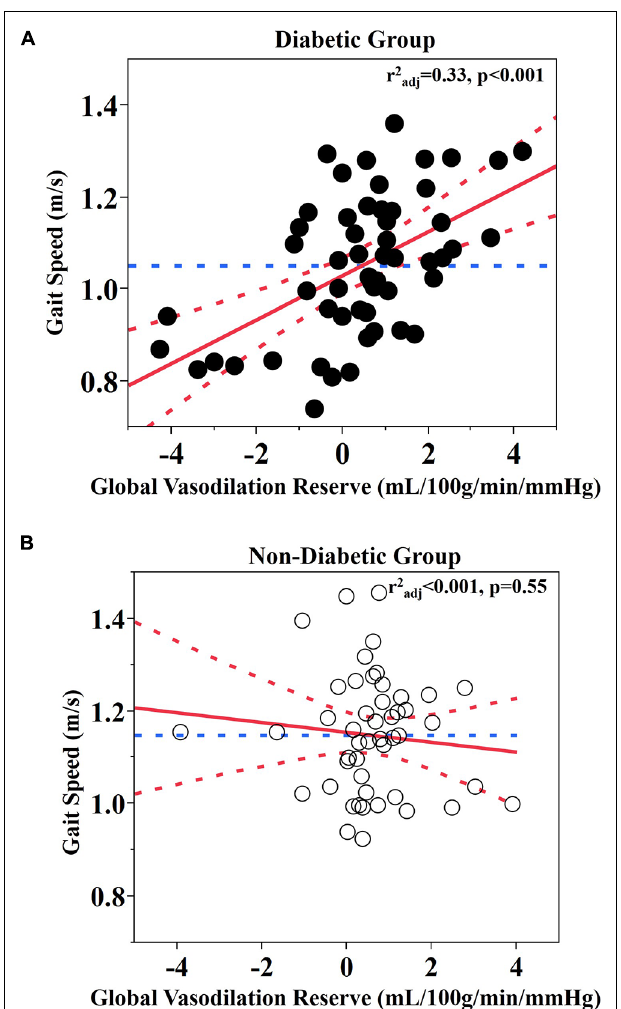
FIGURE 2 | Relationship between global vasodilation reserve and gait speed. (A) Diabetic group (B) Non-diabetic group. Best fit – red solid line; Confidence bounds – red dotted lines; Gait speed mean – blue dotted